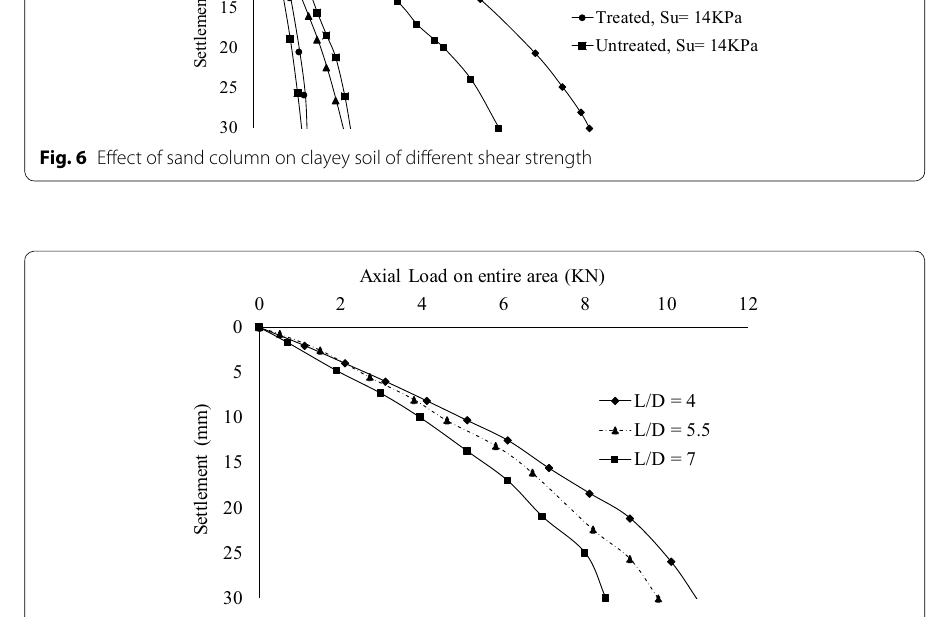
Fig. 7 Effect of L/D of sand column on clayey soil at 32 kPa shear